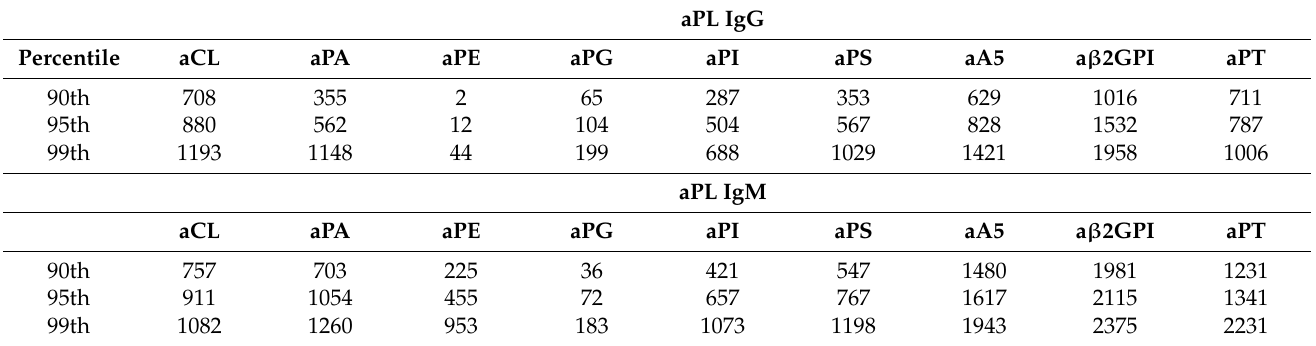
Antiphospholipid antibodies to cardiolipin (aCL), phosphatidic acid (aPA), phosphatidylinositol (aPI), phosphatidylcholine (aPC), phosphatidylethanolamine (aPE), phosphatidylglycerol (aPG), phosphatidylserine (aPS), β2 -glycoprotein- 1 (aβ2GPI), annexin 5 (aA5), and prothrombin (aPT) were determined by LIA. Values are the mean density arbitrary units resulting from the densitom- etry of aPL bands on each LIA strip.